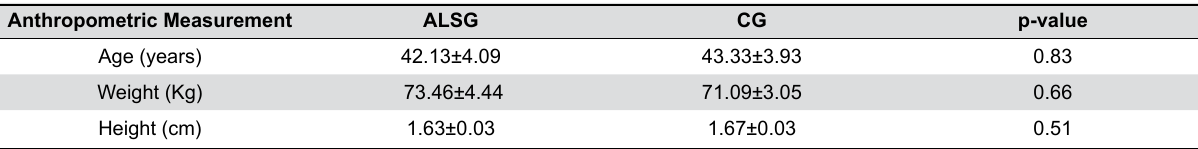
Table 1- Comparison of the mean age and anthropometric measurement according to the groups. ALSG: Amyotrophic lateral sclerosis group; CG: control group. t test